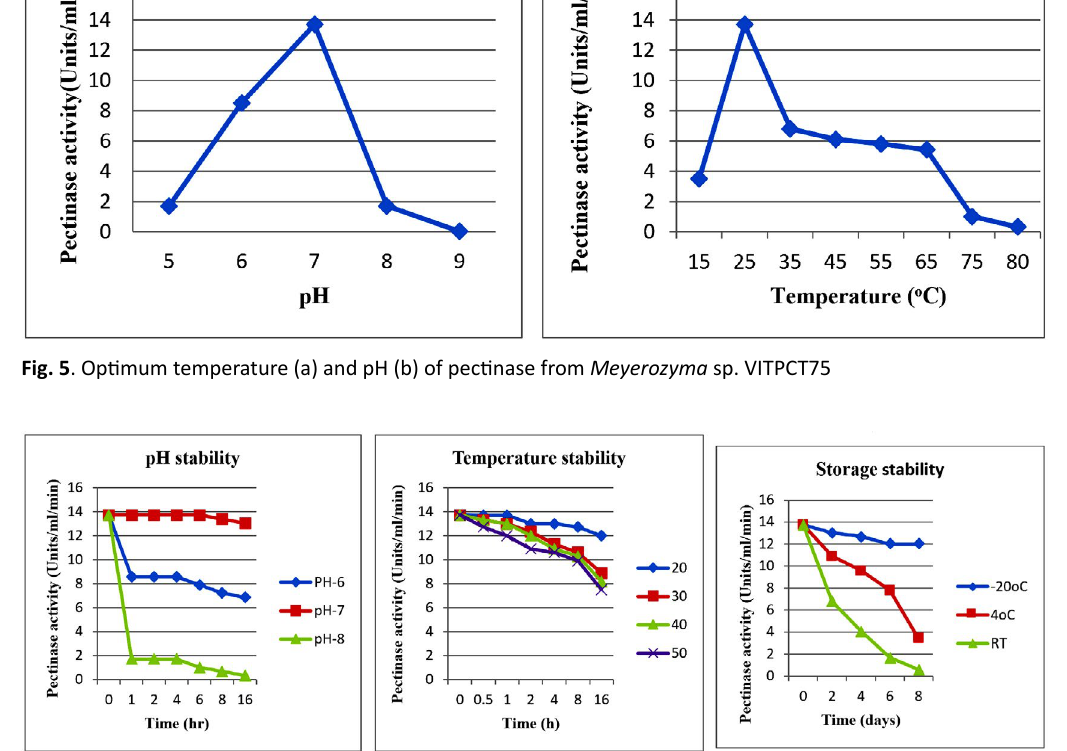
Fig. 6 . Temperature (a), pH (b) and storage (c) stability of pectinase from Meyerozyma sp.